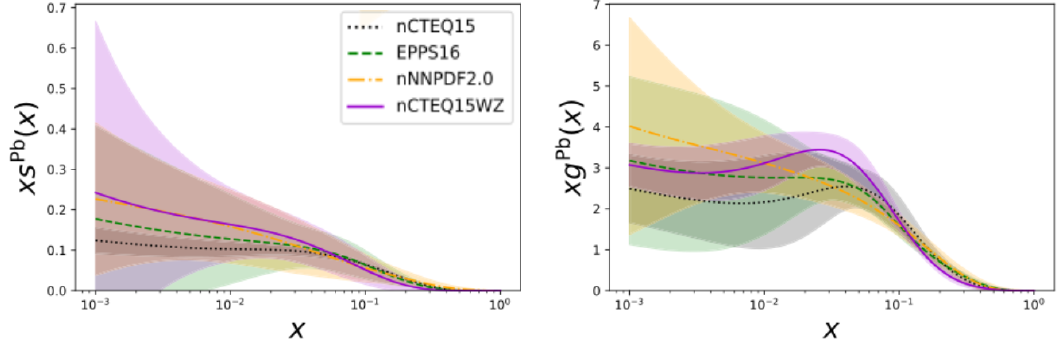
Figure 2: The strange quark and gluon distributions in lead for a selection of nPDFs at Q = 2